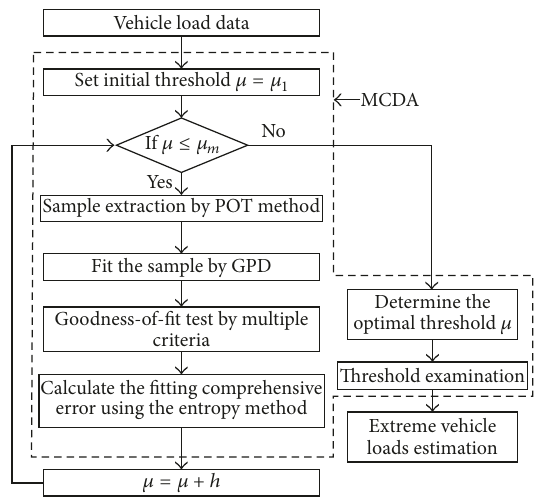
Figure 2: Flowchart of the extreme vehicle loads